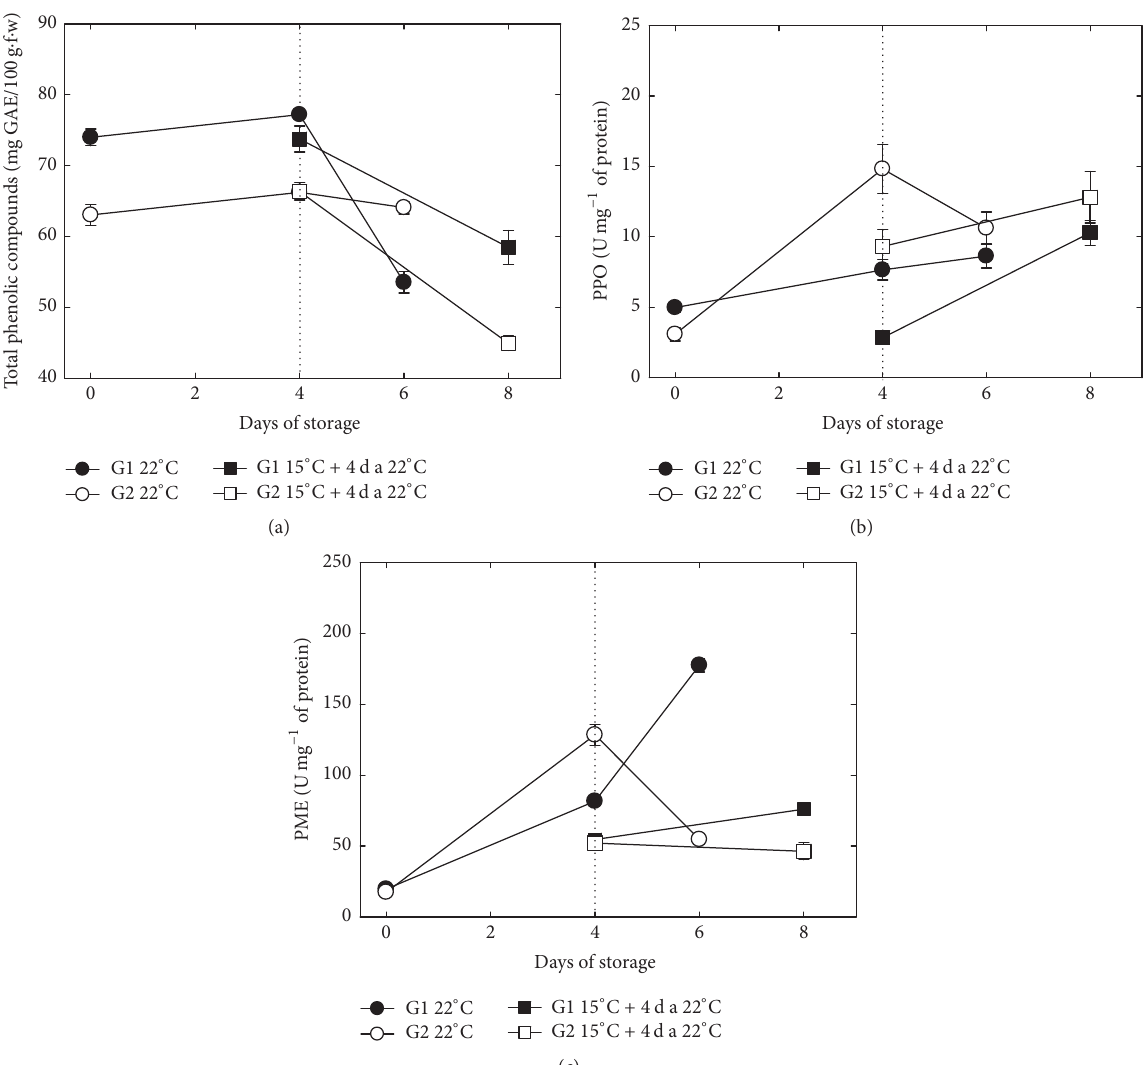
Figure 3: Total phenol content (a) and enzymatic activity of PPO (b) and PME (c) in fruit from two selections of soursop stored at two temperatures, 22 and 15 ∘ C. Each point represents the average of 6 observations and their standard error. The dotted line indicates the end of